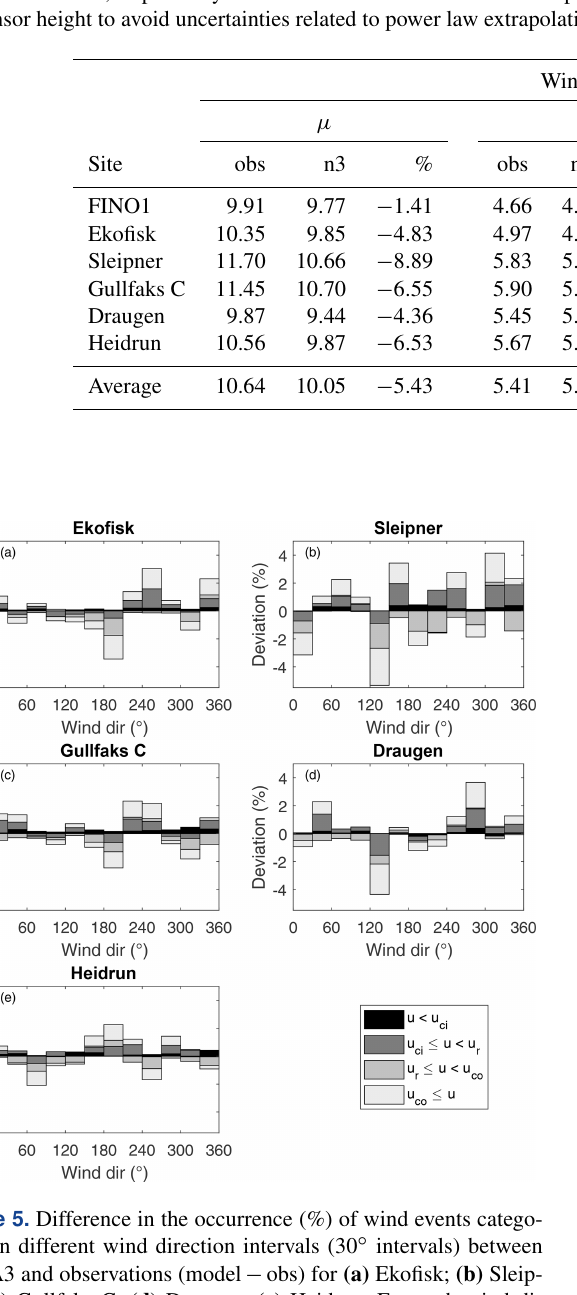
that the modeled and observed data in general show the same wind direction distributions, with only small differ- ences. FINO1 is excluded from the verification of wind di- rection because the wind rose for that site shows a clear directional disturbance, as the wind is affected by the ob- servation mast. Figure 5 graphs the differences between the modeled and observed data (%) in the number of wind di- rection events (30 ◦ intervals) for four wind speed categories no systematic bias in wind direction that can be seen across the sites, and the biases in frequency are less than 5 %